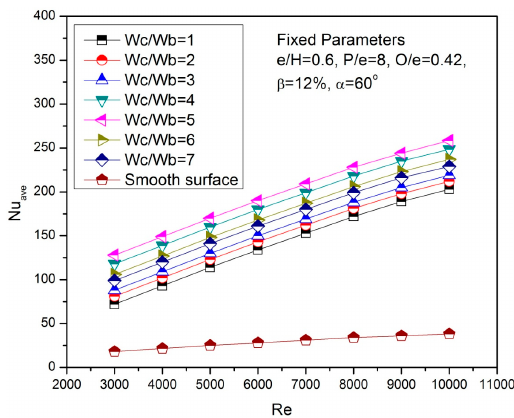
Figure 6. Variation in the average Nusselt number Nu ave with respect to Reynolds number for different Wc / Wb .